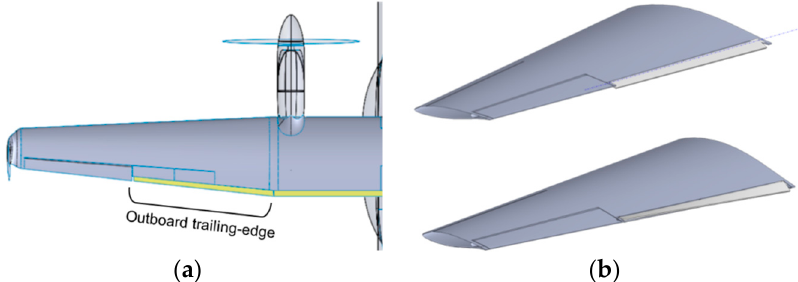
Figure 1. Multifunctional Twistable Wing TE: ( a ) Outboard wing TE, (/flap tab) investigation region for the structural concept; ( b ) Explanation of the outboard wing TE functionalities, ( upper ) rigid deflection of the Fowler flap tip segment, ( lower ) continuous span-wise twist along the outboard wing span.